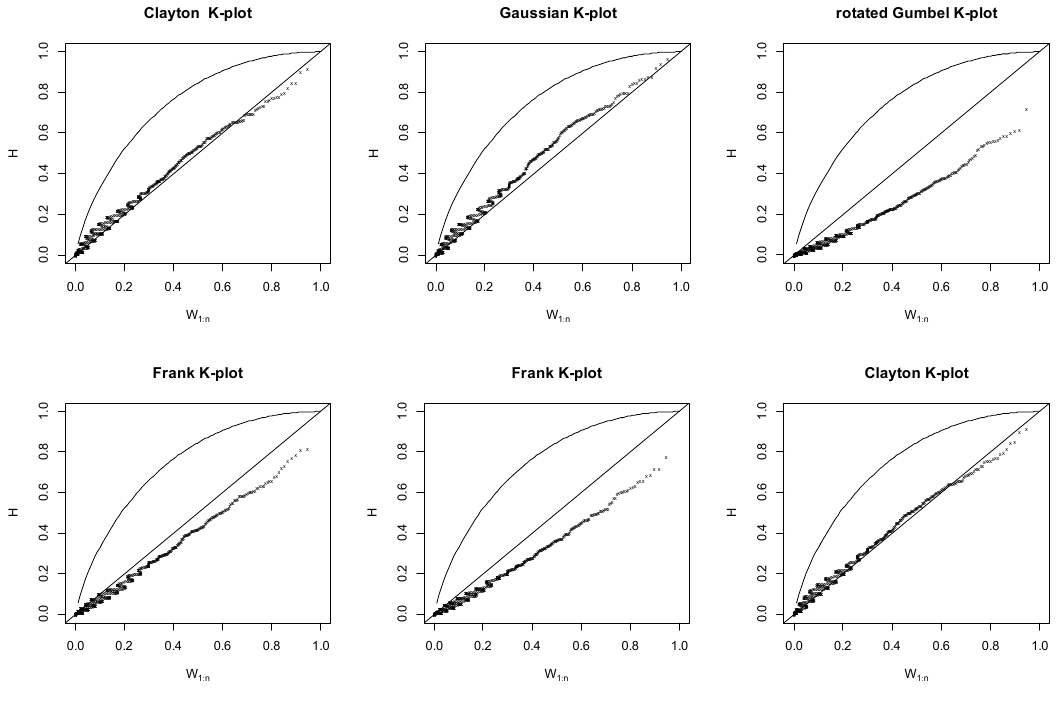
Figure 10. K-plots of pair flood volume variables of Xianyang and Huaxian County.